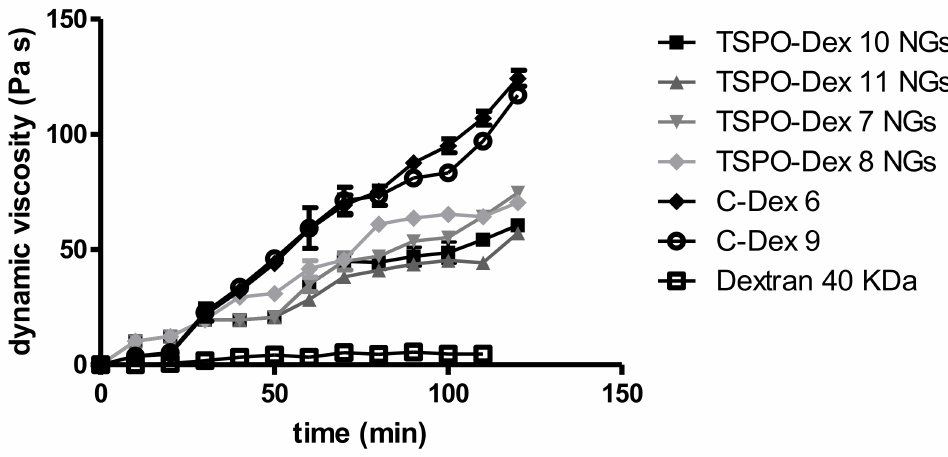
Figure 11. Rheological study of viscoelastic properties of TSPO-DEX